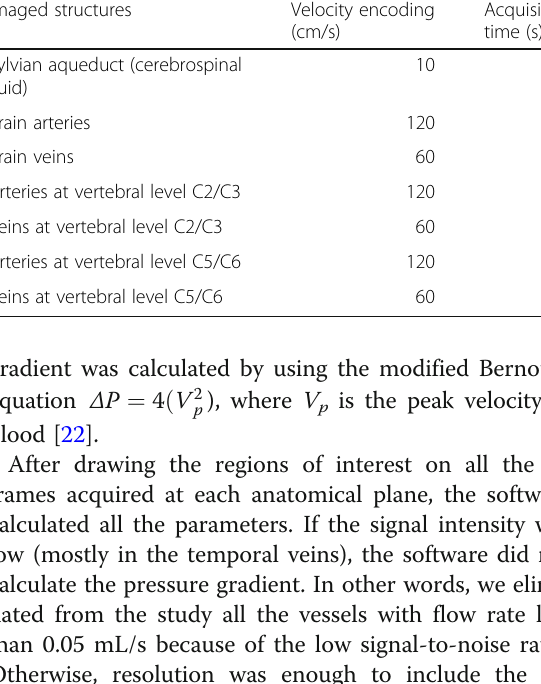
Table 1 Characteristic of the enrolled subjects Demographic characteristics